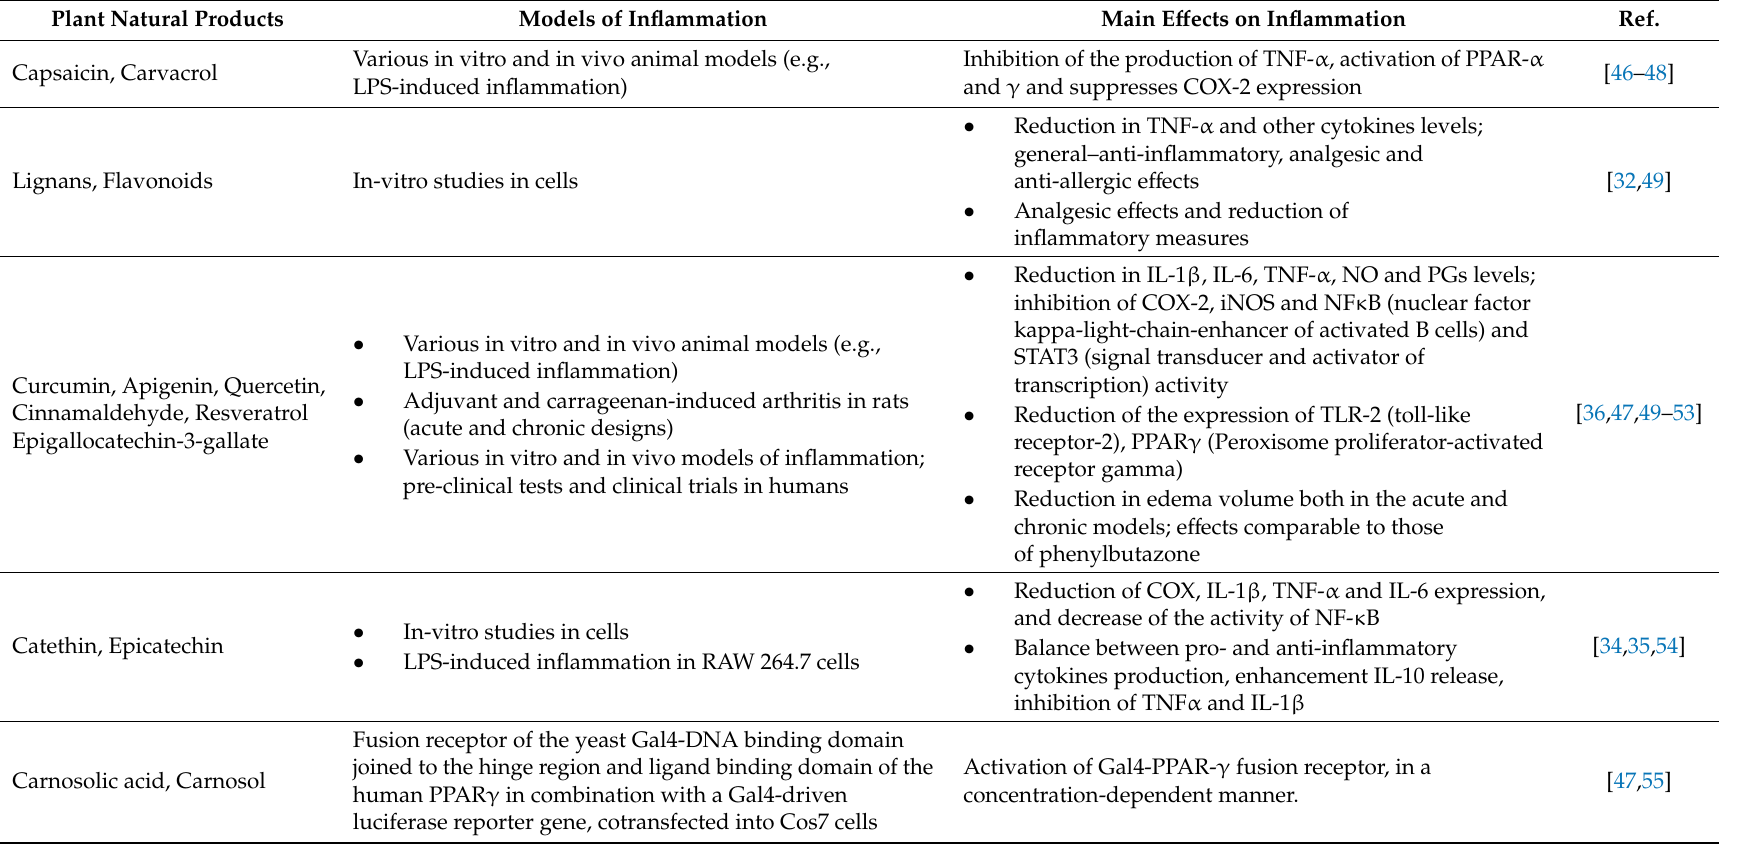
Main E ff ects on